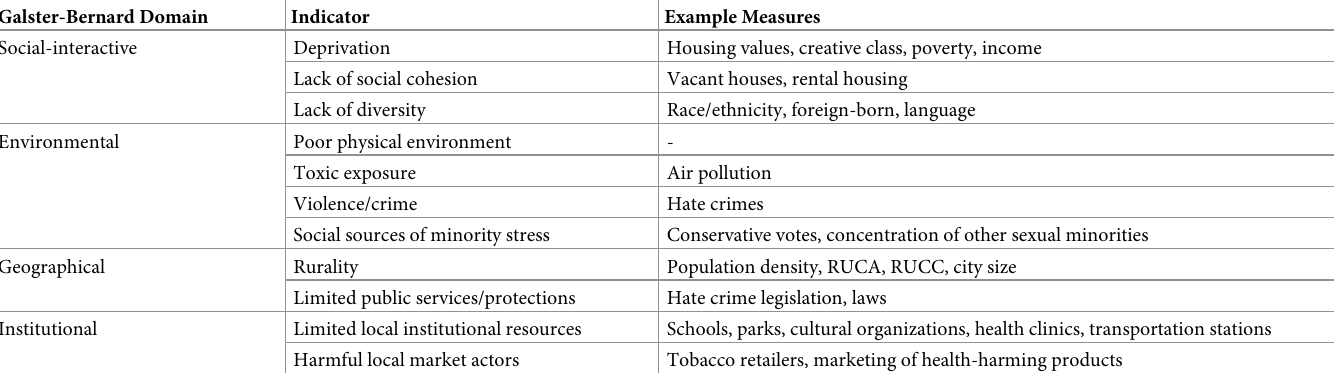
Table 1. Categorization and example indicators of neighborhood domains of influence on